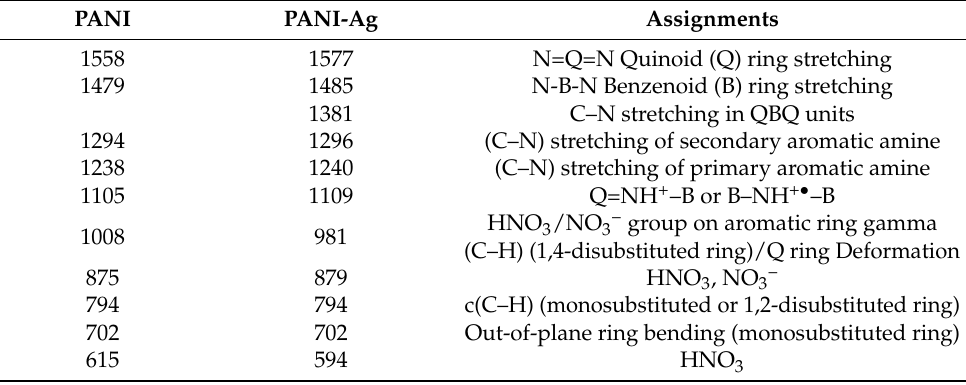
Figure 4. SEM images of PANI and the PANI-Ag composite.